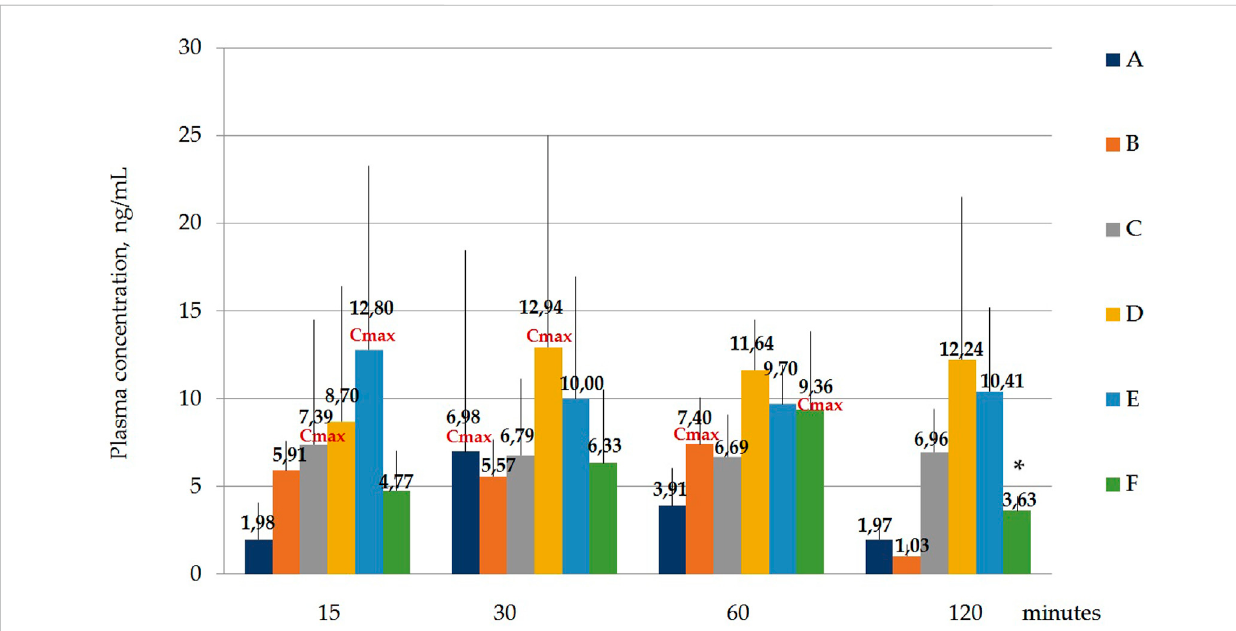
FIGURE 4 Concentration of laterpirdine for polymorphs (A – F) in blood serum samples. Data are presented as means of all polymorphs at each time point + standard deviation. The graph shows thevalues ofthemaximum concentrationfor each polymorph (Cmax). Blood Tmax isthetime pointatwhichCmax is observed. * — p ≤ 0.05 relative to the “ 60 min ” time point for each Polymorph according to the Kruskal – Wallis test.